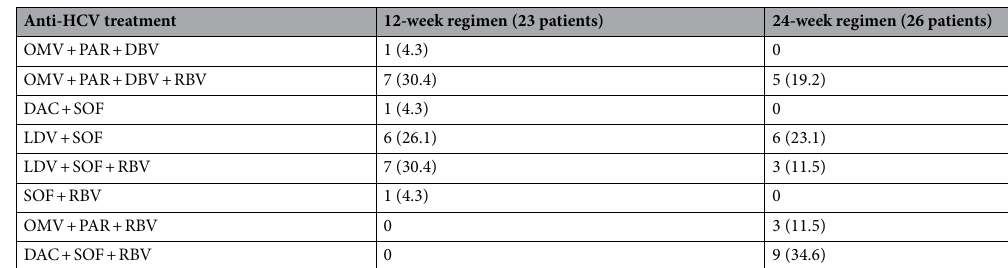
Table 1. Description of HCV drug regimens prescribed for 12 weeks (23 patients) or for 24 weeks (26 patients). Data are expressed as absolute number and percentage (respect to the number of subjects included in the regimen). OMV ritonavir boosted ombitasvir, PAR paritaprevir, DBV dasabuvir, RBV ribavirin, DAC daclatasvir, LDV ledipasvir, SOF sofosbuvir.